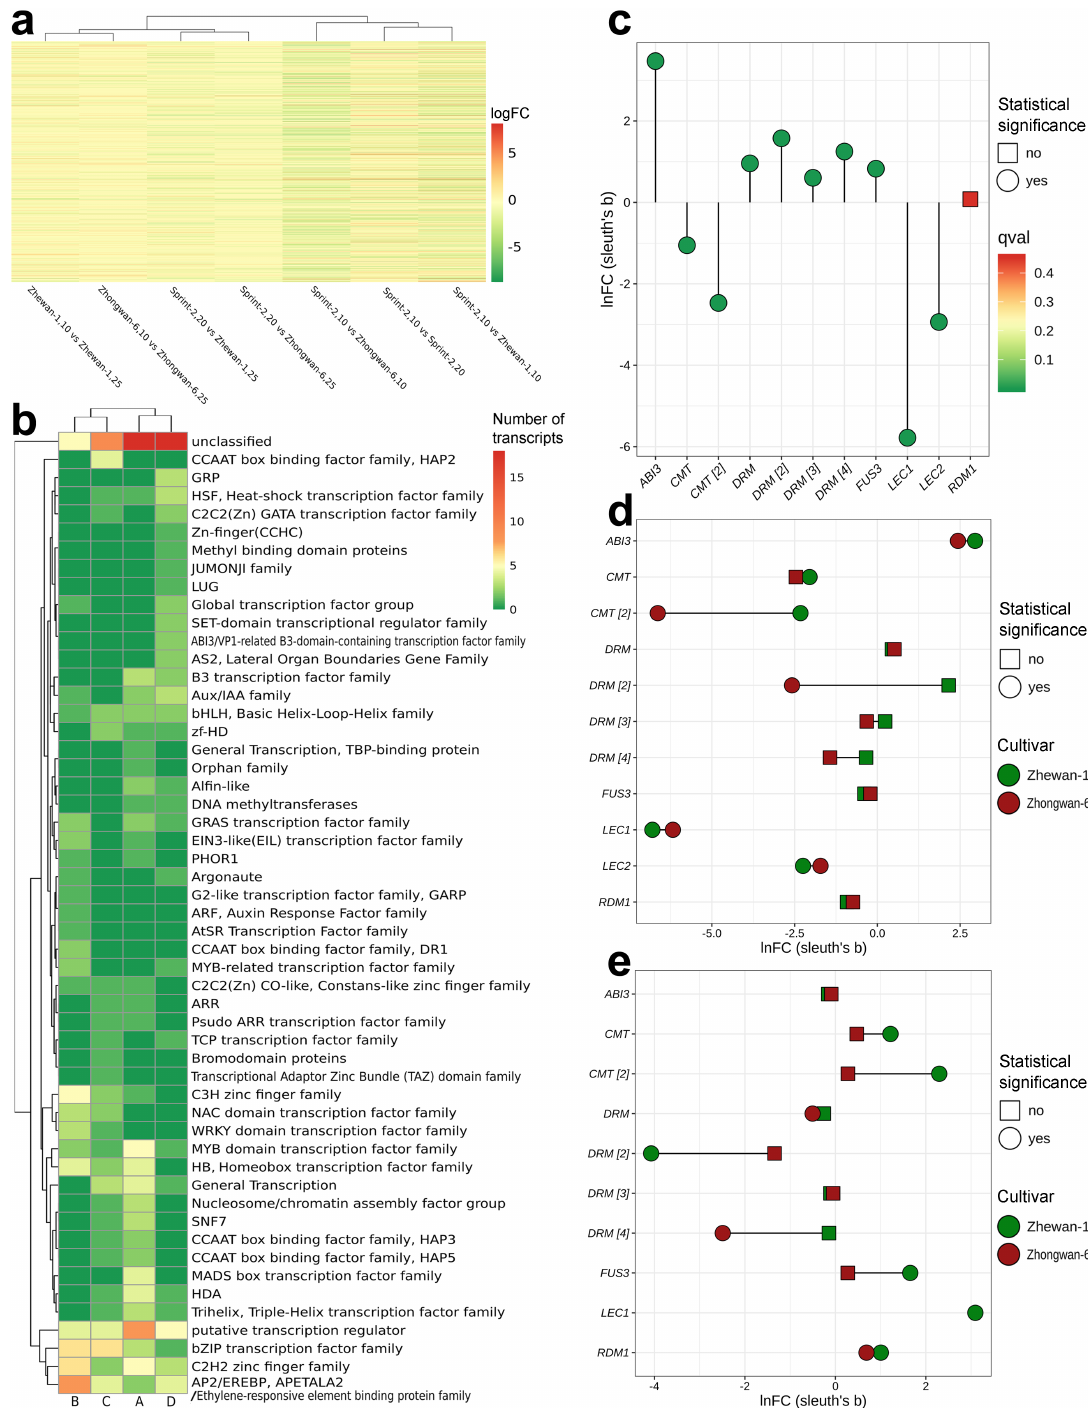
Figure 11. Expression dynamics of transcripts encoding transcription regulators. ( a ) Heatmap of expression changes in di ff erent comparisons. Plotted are logFC changes in the respective comparisons, where clustering was performed using Euclidean distances between samples. ( b ) Heatmap of MapMan terms related to transcription regulation a ff ected by the di ff erential expression. Columns denote SOM group overexpression spots A–D. Plotted are the numbers of transcripts annotated to the respective category. ( c – e ) Expression of transcripts encoding AFL factors and DNA methylases. Numeric axis values indicate logFC changes in respective DE tests. ( c ) Changes between 10 and 20 DAP seeds of Sprint-2. ( d ) Di ff erential expression between Sprint-2 and Zhewan-1 / Zhongwan-6 seeds at 10 DAP. ( e ) Di ff erential expression between Sprint-2 and Zhewan-1 / Zhongwan-6 mature